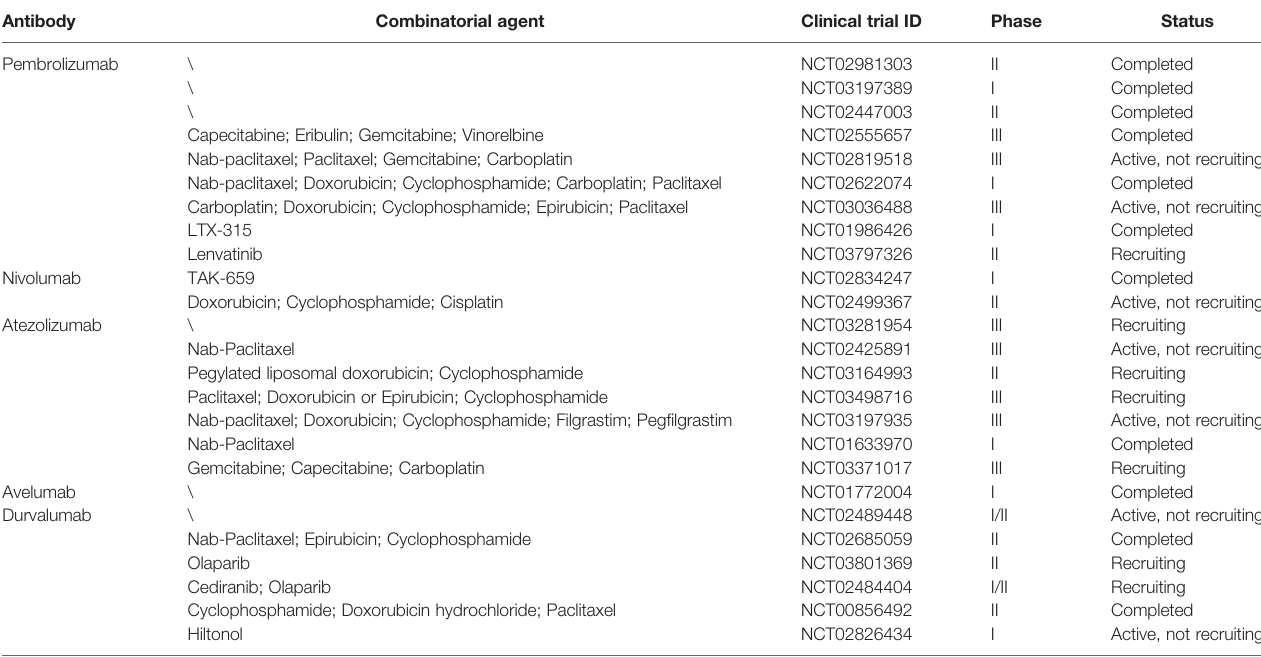
TABLE 2 | PD1/PDL1 inhibitors in TNBC immunotherapy for clinical